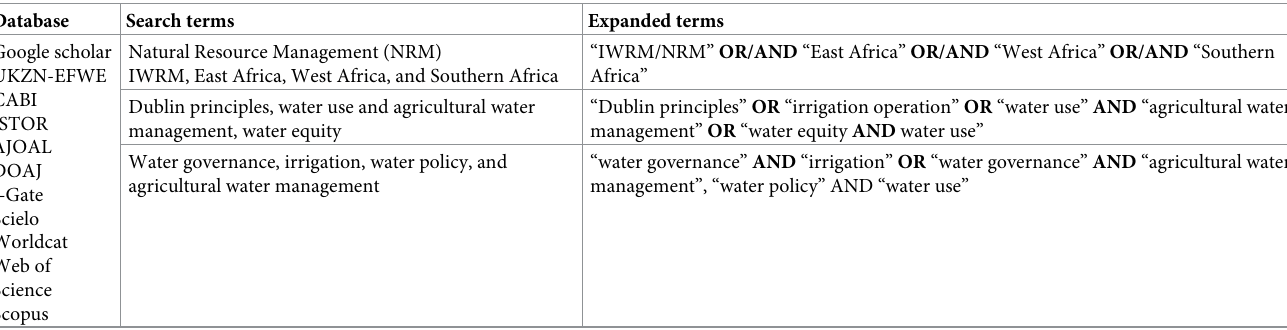
Table 2. Search strategy employed in the study.